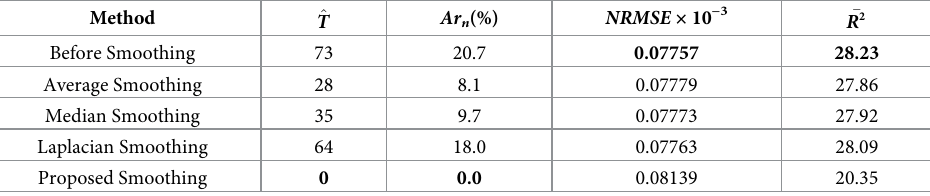
Table 5. Comparison of different methods in fitting the fMRI time